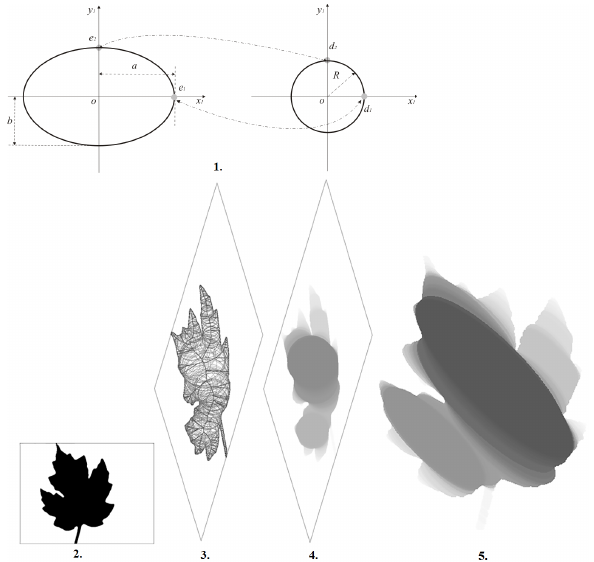
Figure 4: Basic ideas for pattern spectrum algorithm construction with fixed elliptical SE. The most important steps are shown. 1. Equi-affine transformation elliptical SE to disc SE; 2. Original 2D Shape; 3. Disc skeleton of equi-affine transformed polygonal shape; 4. Disc thickness map of transformed shape; 5. Elliptical thickness map obtained from disc thickness map by equi-affine transformation of disc SE to elliptical SE.